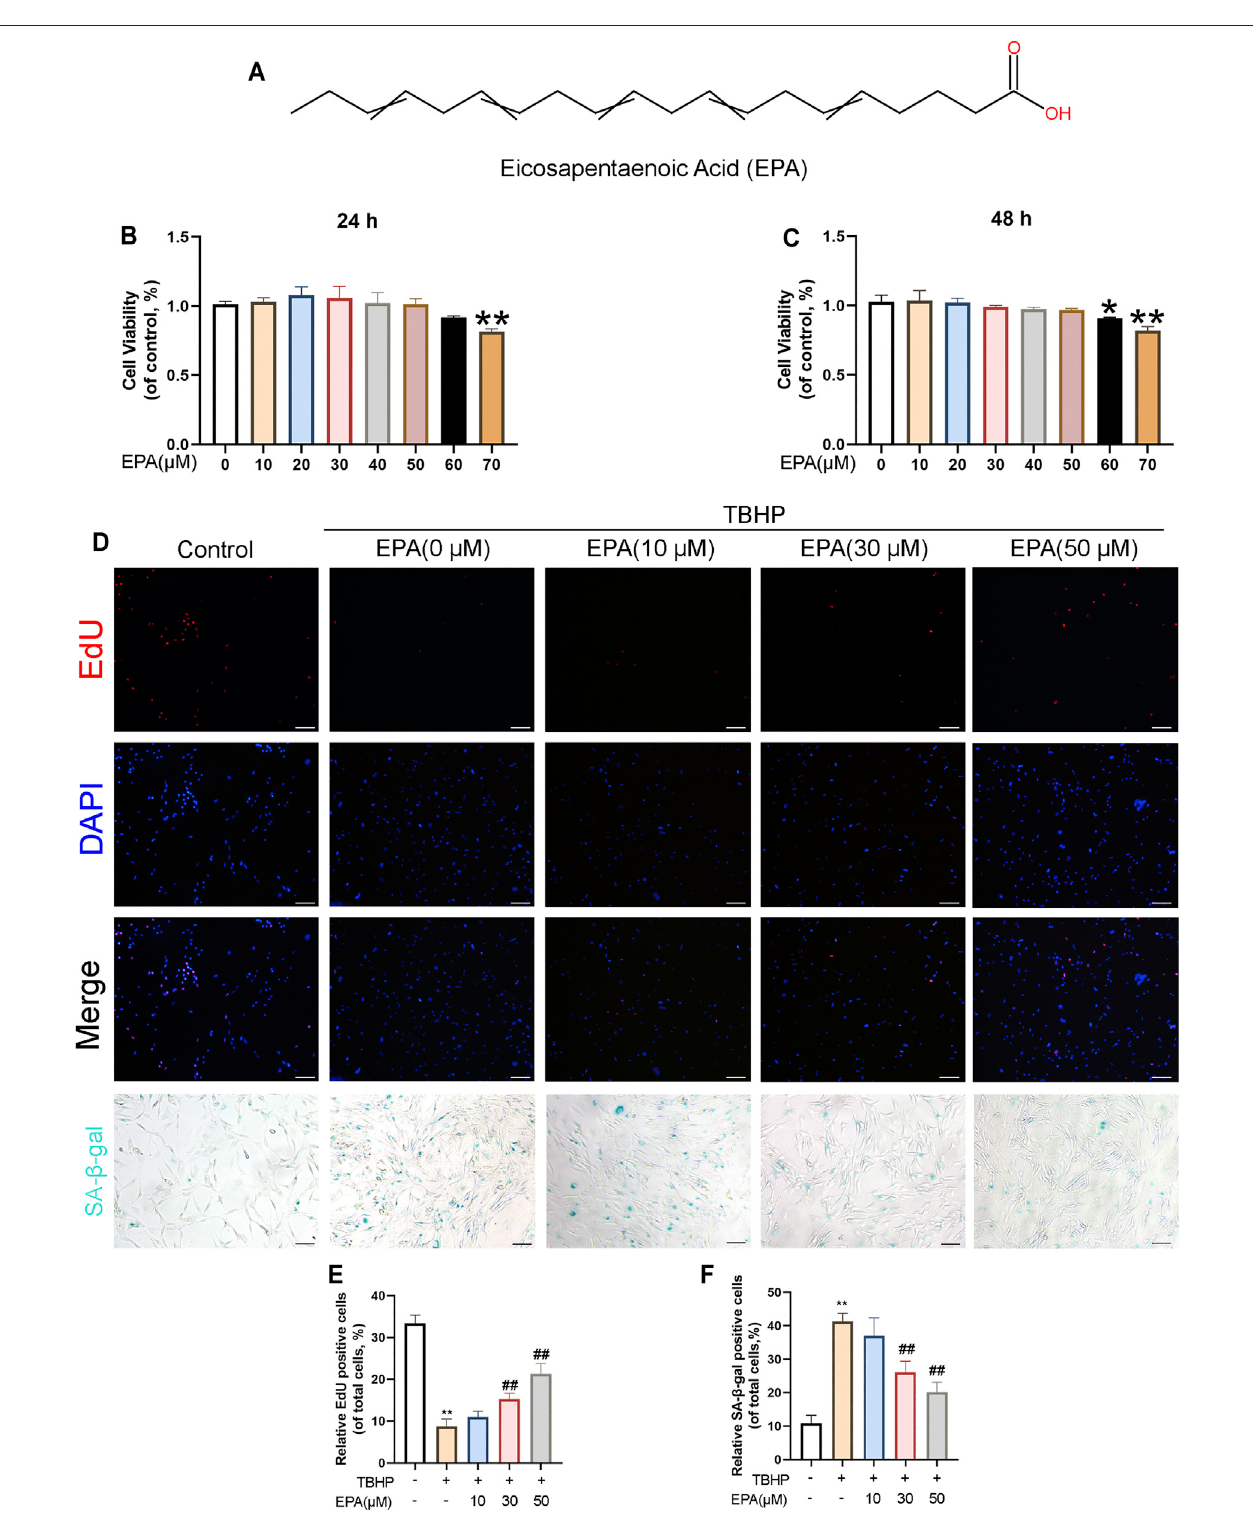
FIGURE 1 | The effect of EPA on the vitality of NPCs. (A) Chemical structure of EPA. (B,C) The cytotoxic effect of EPA in the NPCs was determined at various concentrations for 24 and 48 h by a CCK8 assay. (D,E) EdU staining assay was detected (red). Nuclei were counterstained with DAPI (blue) (scale bar: 100 μ m). (D,F) And SA- β -gal staining was detected (scale bar: 100 μ m). The values presented are the means ± SD ( n (cid:2) 3). * p < 0.05, ** p < 0.01. # p < 0.05, ## p < 0.01, compared with the TBHP treatment group.